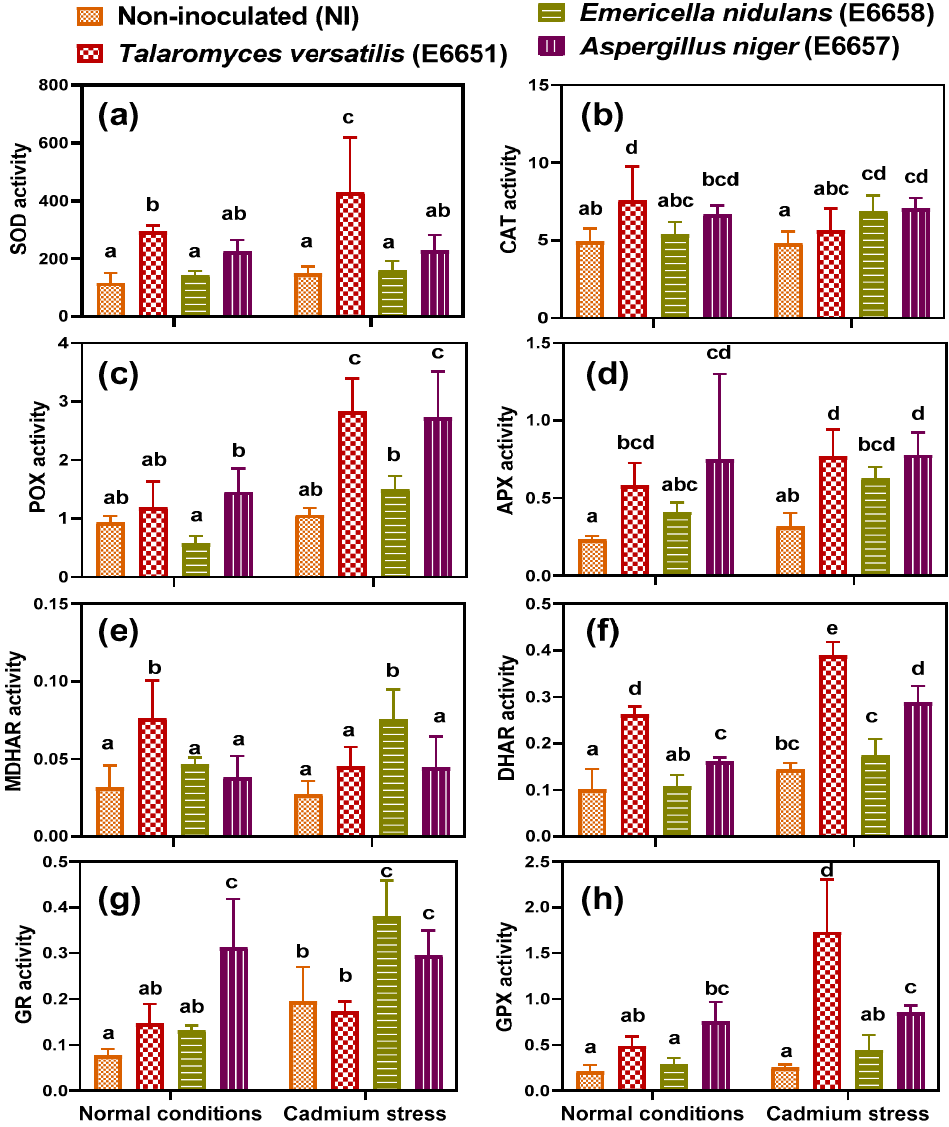
Figure 2. ( a ) Superoxide dismutase (SOD, USOD mg − 1 (protein) min − 1 ), ( b ) catalase (CAT, µmol H 2 O 2 mg − 1 (protein) min − 1 ), ( c ) peroxidase (POX, µmol oxidized pyrogallol mg − 1 (protein) min − 1 ), ( d ) ascorbate peroxidase (APX, µmol AsA mg − 1 (protein) min − 1 ), ( e ) monodehydroascorbate reductase (MDHAR, µmol NADH mg − 1 (protein) min − 1 ), ( f ) dehydroascorbate reductase (DHAR, µmol AsA mg − 1 (protein) min − 1 ), ( g ) glutathione reductase (GR, µmol NADPH mg − 1 (protein) min − 1 ) and ( h ) glutathione peroxidase (GPX, µmol NADPH mg − 1 (protein) min − 1 ) activities in leaves of geranium non-inoculated (NI)